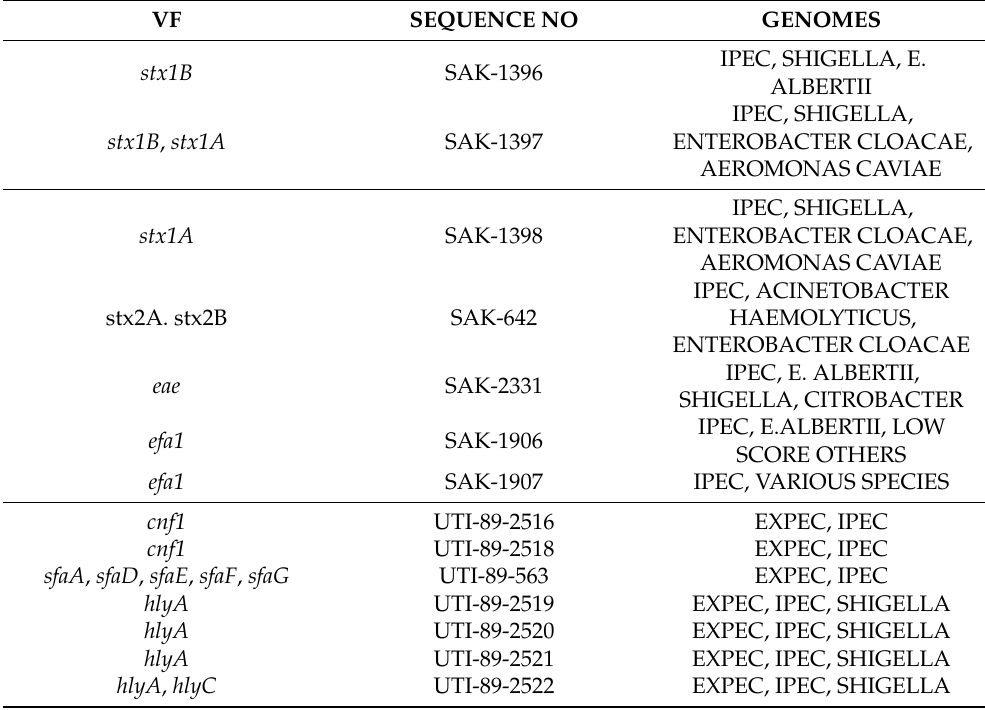
Table 4. Selected genomic fragments of the O157:H7 Sakai and UTI89 genomes found within sequences of typical IPEC/ExPEC virulence factors present in bacterial